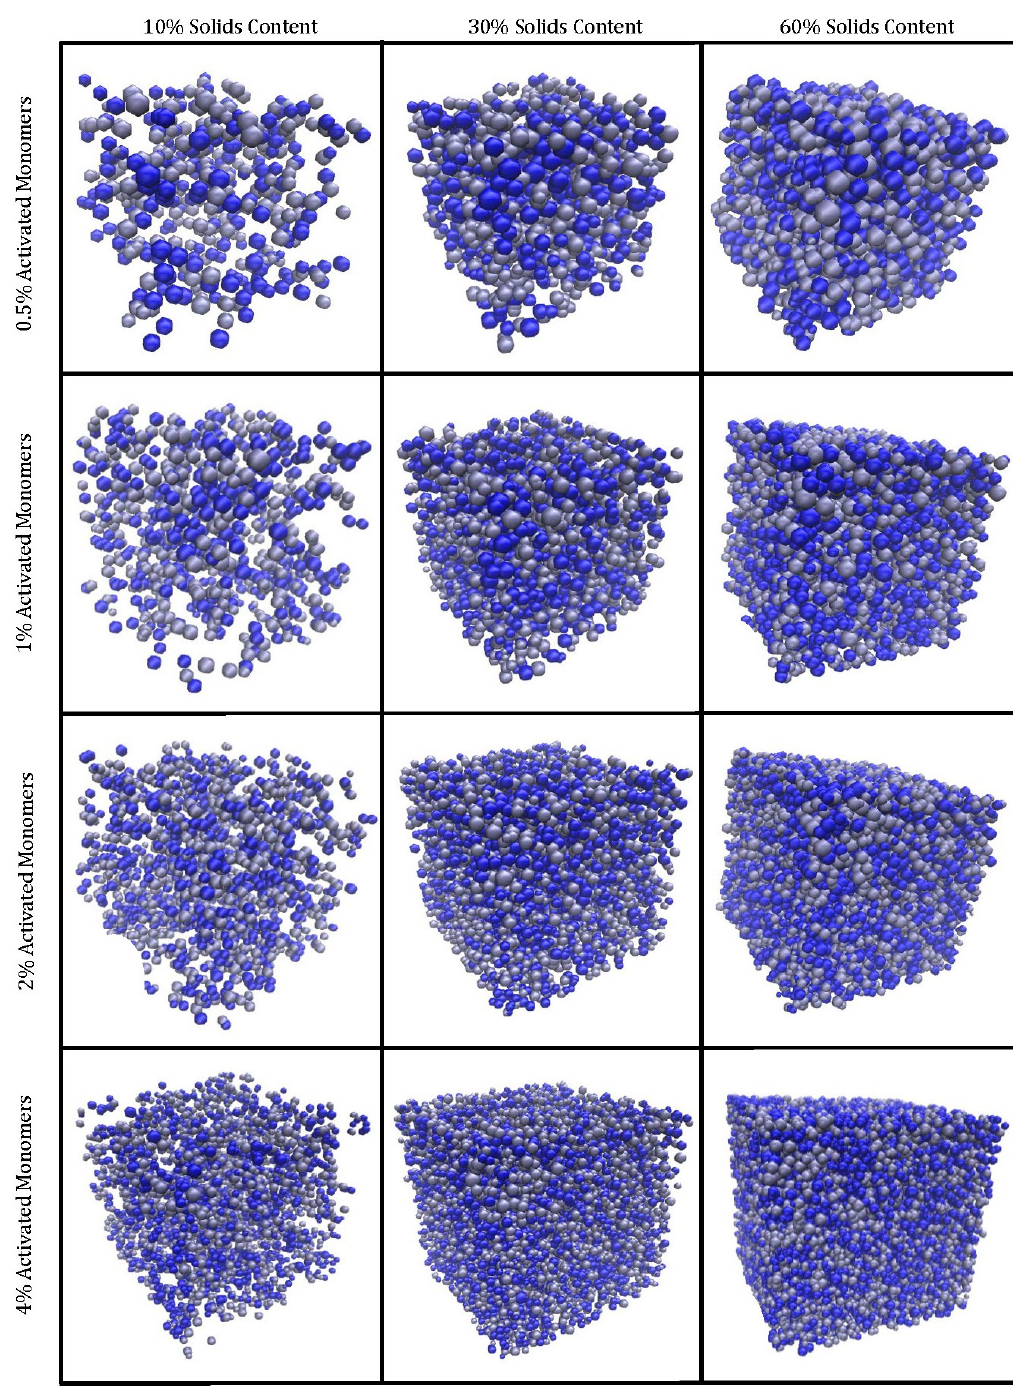
Figure 3. Simulated RF gel materials visualised in 3D, with increasing solids content ( S c ), left to right, and an increasing percentage of activated monomers ( C c ), top to bottom. Note that each sphere represents an individual cluster, and the different colours of clusters present are for visual purposes only.